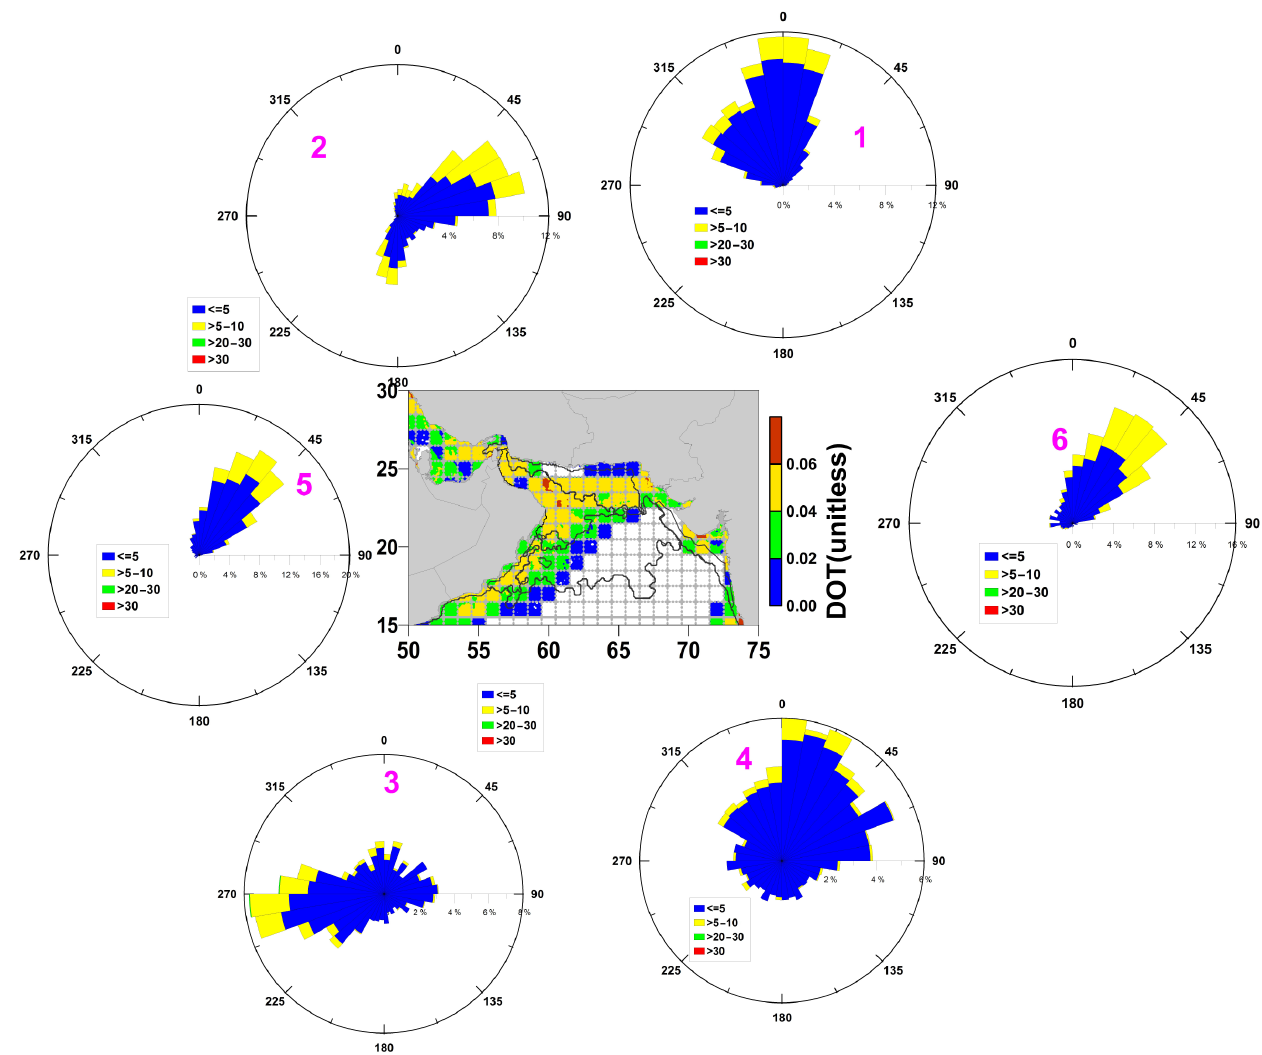
Figure A2. Wind rose diagram for the six zones. Zone number corresponding to wind rose plot is provided in pink